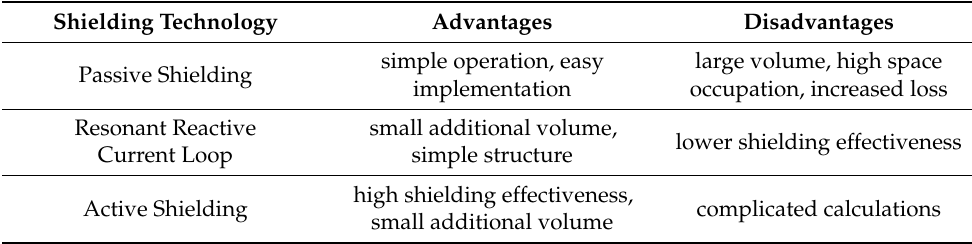
Table A2. Features of various shielding technologies in